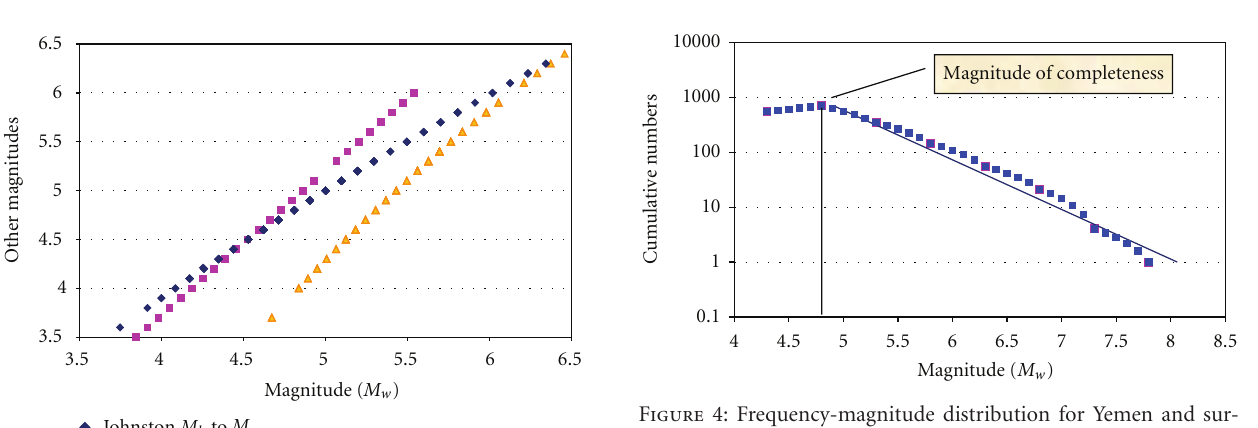
Figure 2: Yemen composite catalogue.